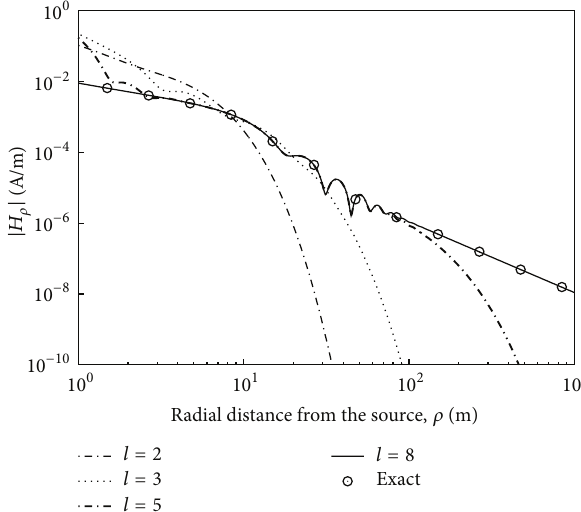
Figure 6: Profiles of |𝐻 𝜌 | against the radial distance from the source point.